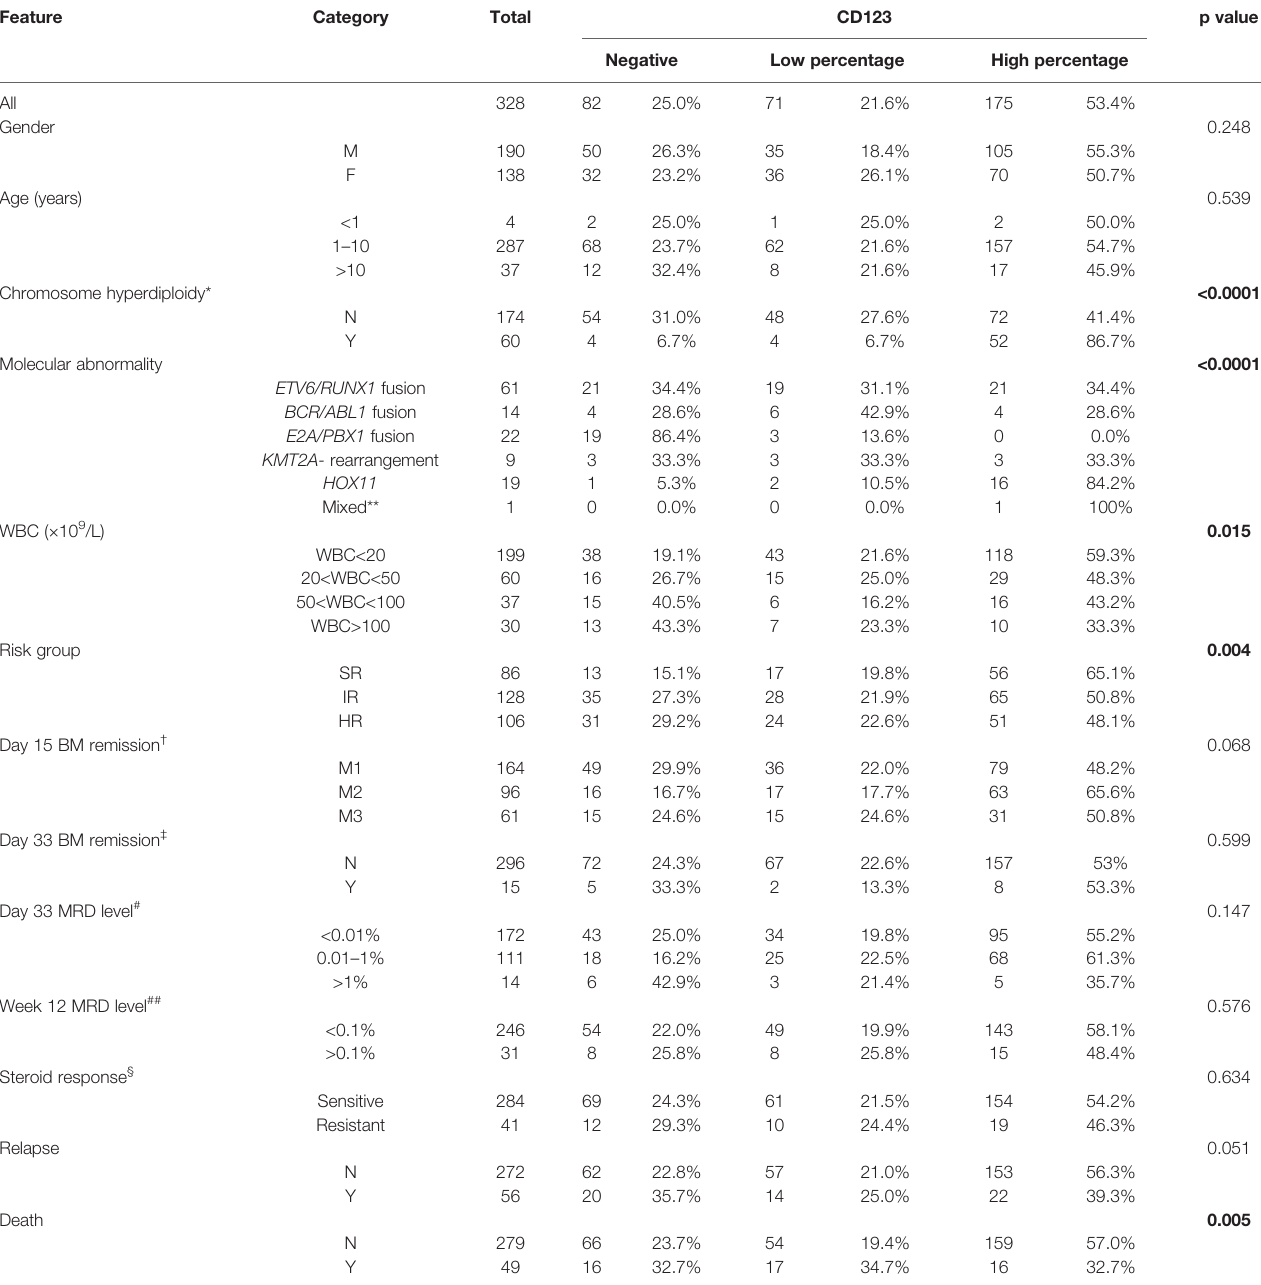
TABLE 1 | Correlation of CD123 expression with clinicopathological features of pediatric B-ALL patients treated with CCLG-ALL-2008 protocol.